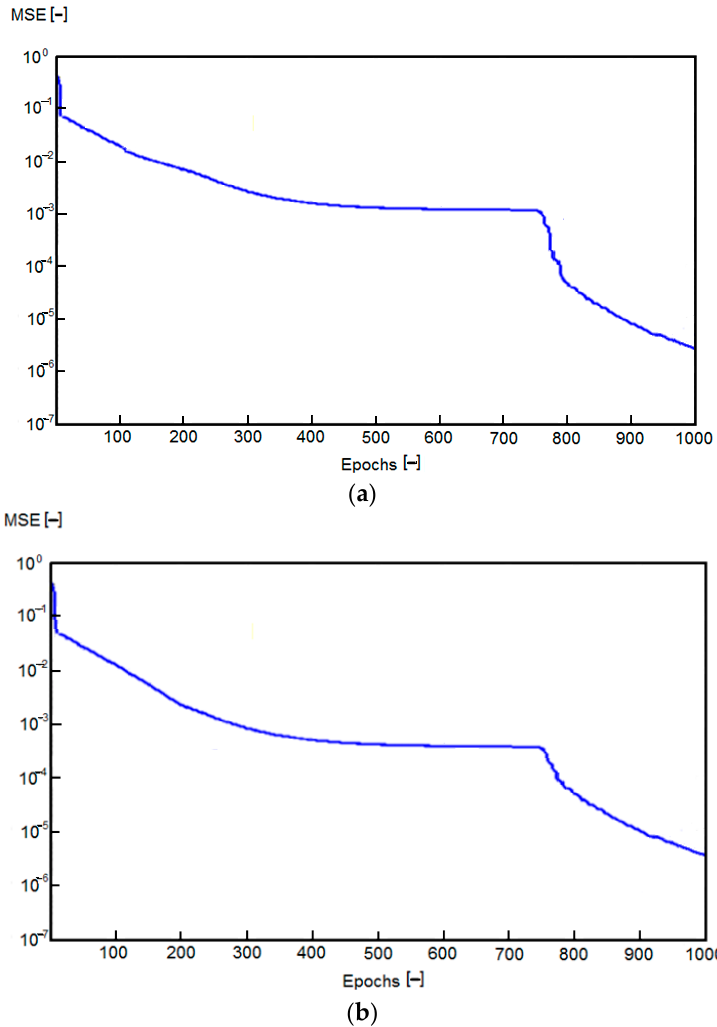
Figure 5. Values of the mean square error (MSE) during learning: ( a ) optimal MLP 54-70-4, ( b ) non-optimal MLP 54-90-4.